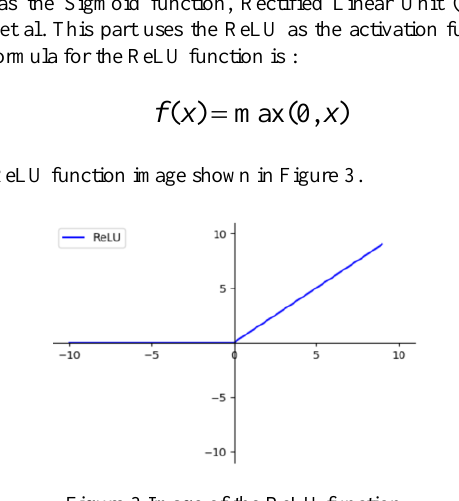
Figure 3 Image of the ReLU function.